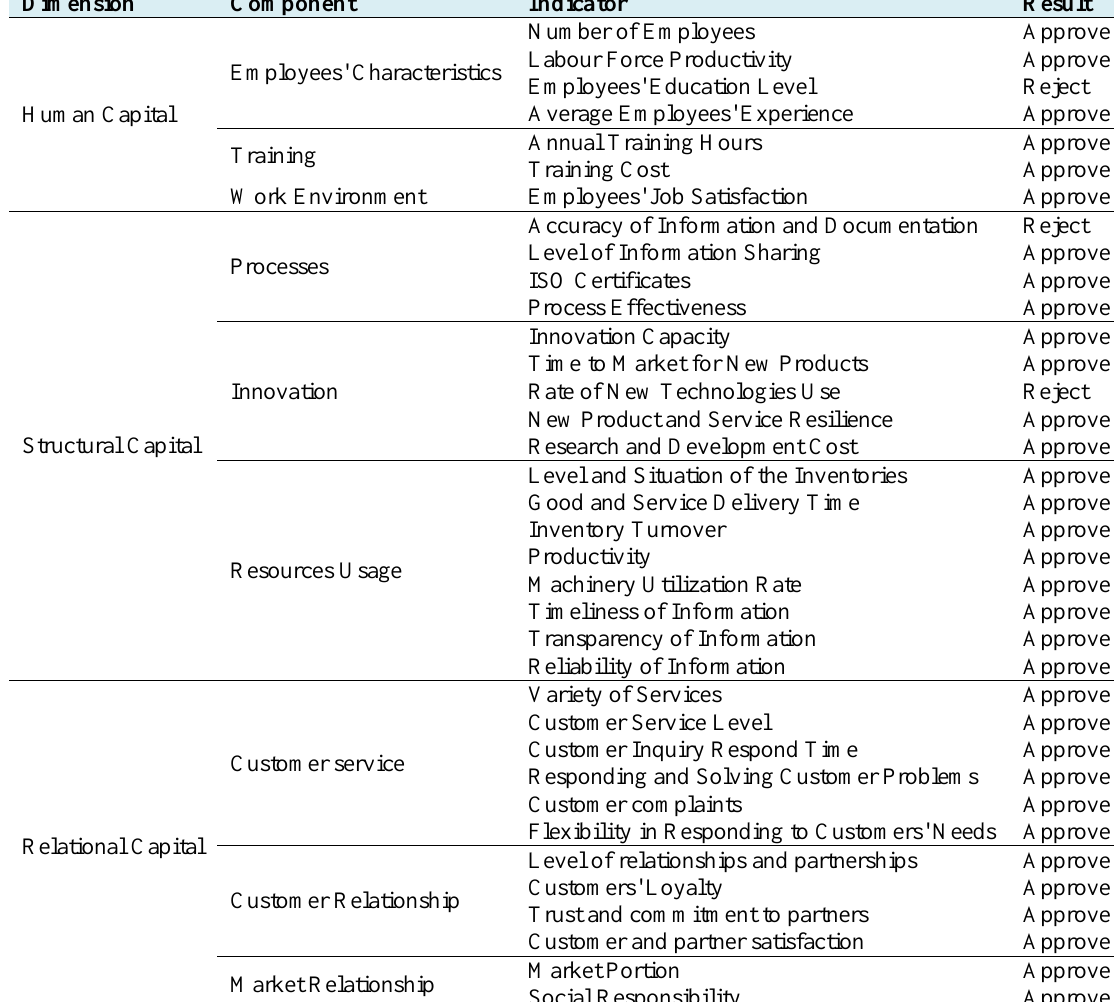
Table 2. Dimensions, Components, and Indicators of Modified